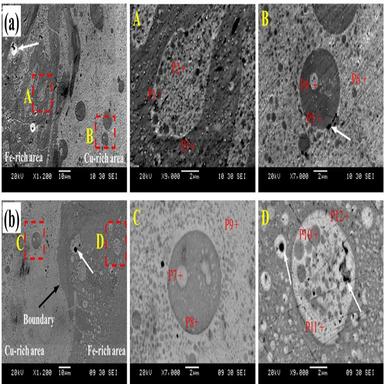
(a) Melt behaviour at the L/C interface; (b) Melt pool behaviour at the C/L interface.